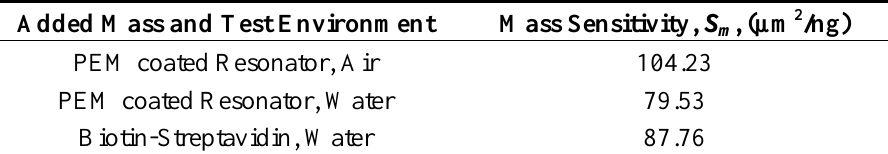
Table 1. Measured resonancefrequency and mass sensitivity of sensorscoated with PEM and Biotin-Streptavidin binding in air and